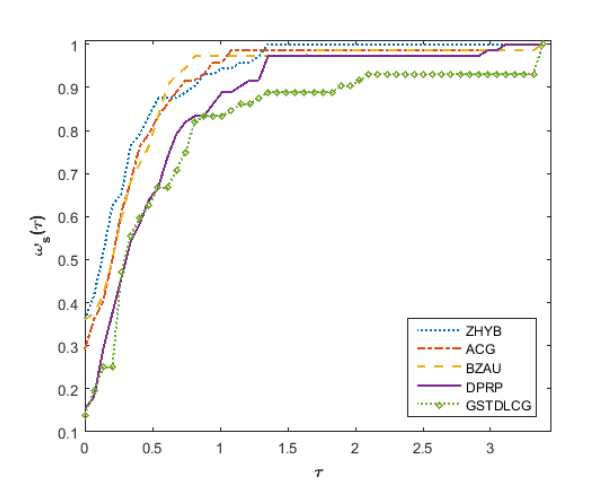
Figure 3: Number of gradient evaluations performance profiles